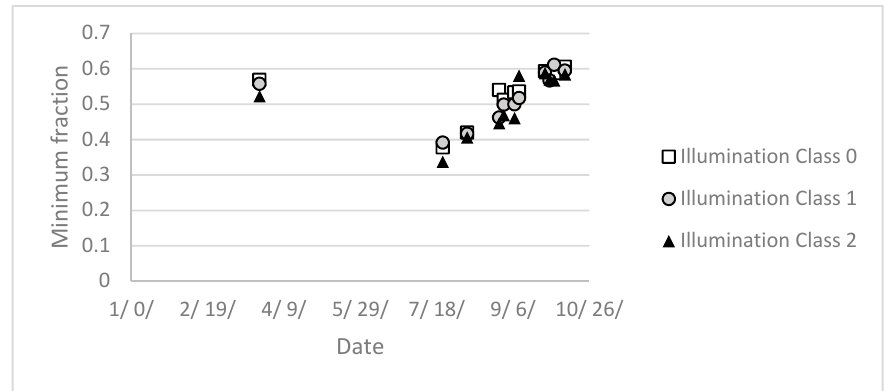
Figure 10. Minimum threshold value for gap fraction.